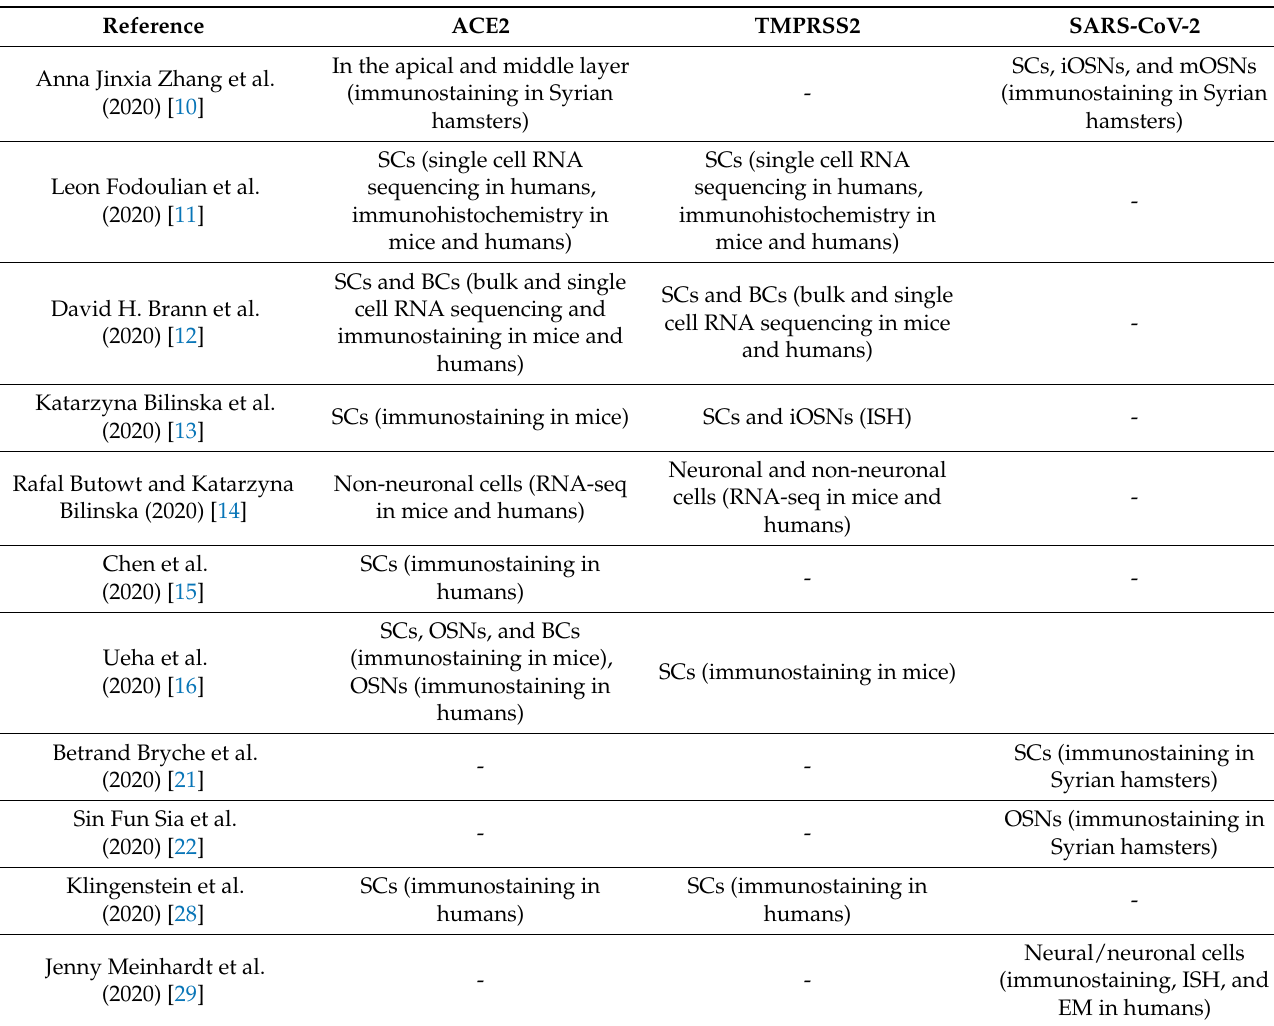
Table 3. Previous studies regarding SARS-CoV-2 infection in the main olfactory epithelium.